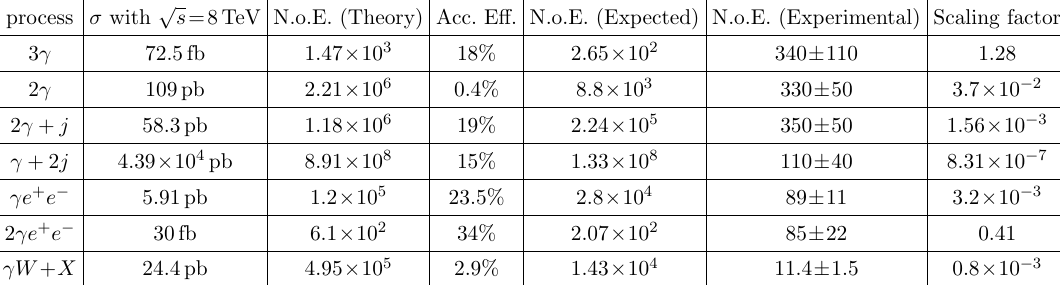
Table 5. The scaling factors for each process of SM background are shown where N.o.E.